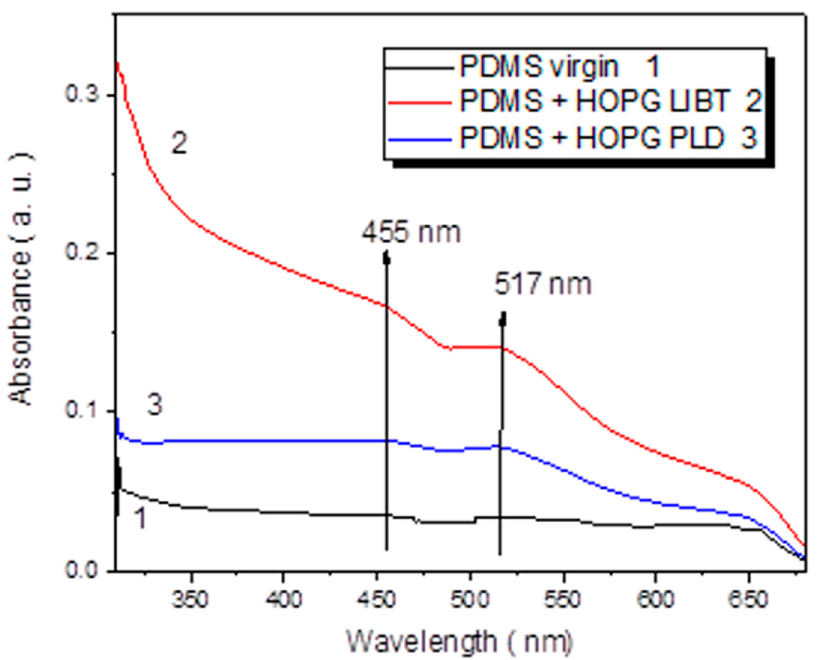
Figure 8. Optical spectra of PDMS virgin (curve 1) and deposited with HOPG by PLD (curve 3) and LIBT (curve 2).